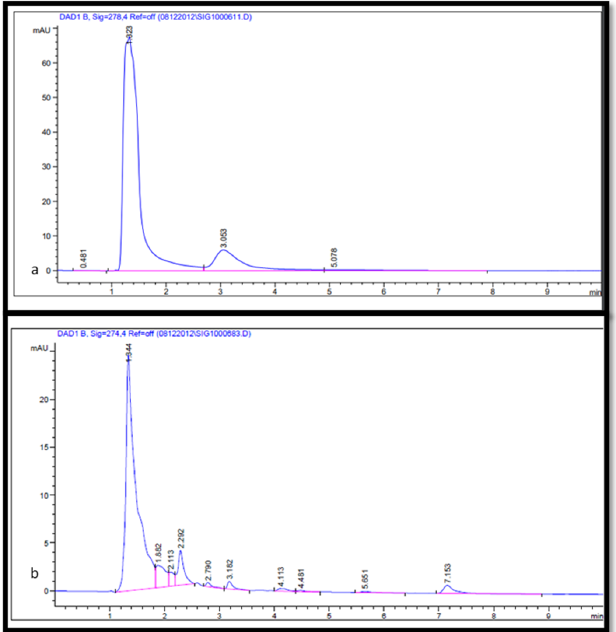
Figure 4. ( a ) HPLC chromatogram of the tannic acid standard (at 274 nm). ( b ) HPLC chromatogram of the tannin compound in the plant extract (at 274nm) shows retention time at 1.323